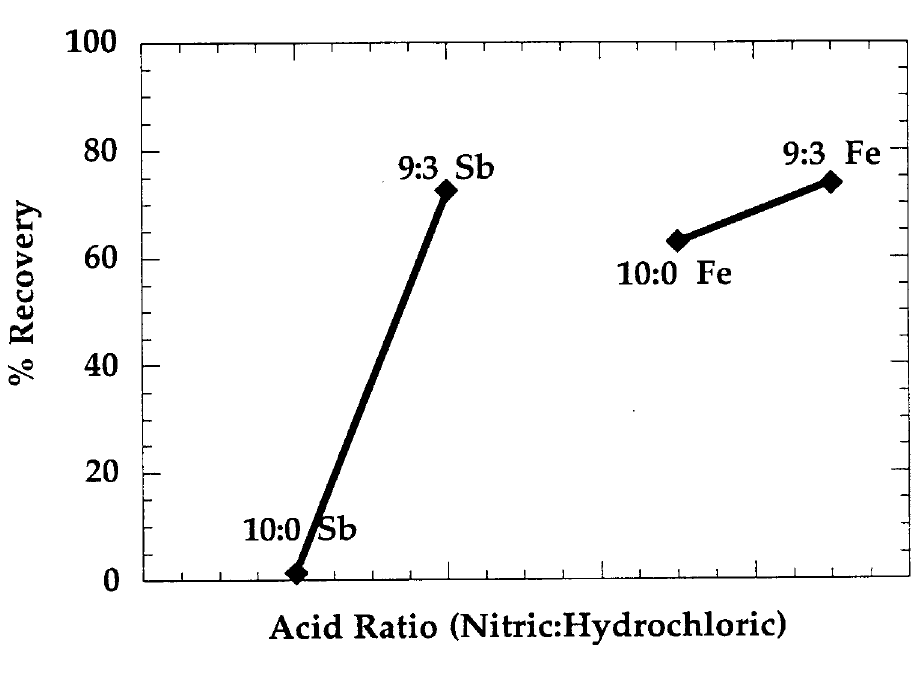
PERCENT RECOVERY OF ANTIMONY AND IRON, RESPECTIVELY, FROM SRM 4355 (PERUVIAN SOIL) USING BOTH DIGEST OPTIONS